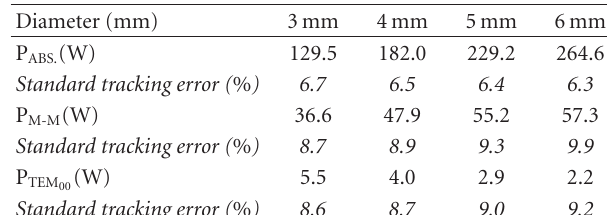
Table 1: Laser output performance and the respective standard 2mrad tracking errors for the laser rods of di ff erent diameters, pumped by the 3D-CPC-2D-CPC